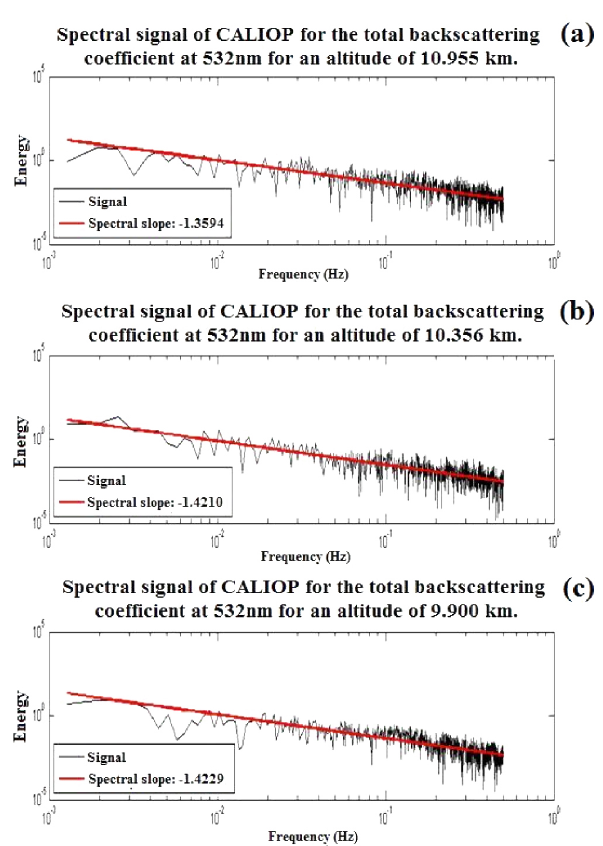
Figure 3. Spectral slopes of the CALIOP/CALIPSO backscattering coefficient at 532nm observed at 10.955km (a) , 10.356km (b) and 9.900km (c) as a function of the frequency in Hz